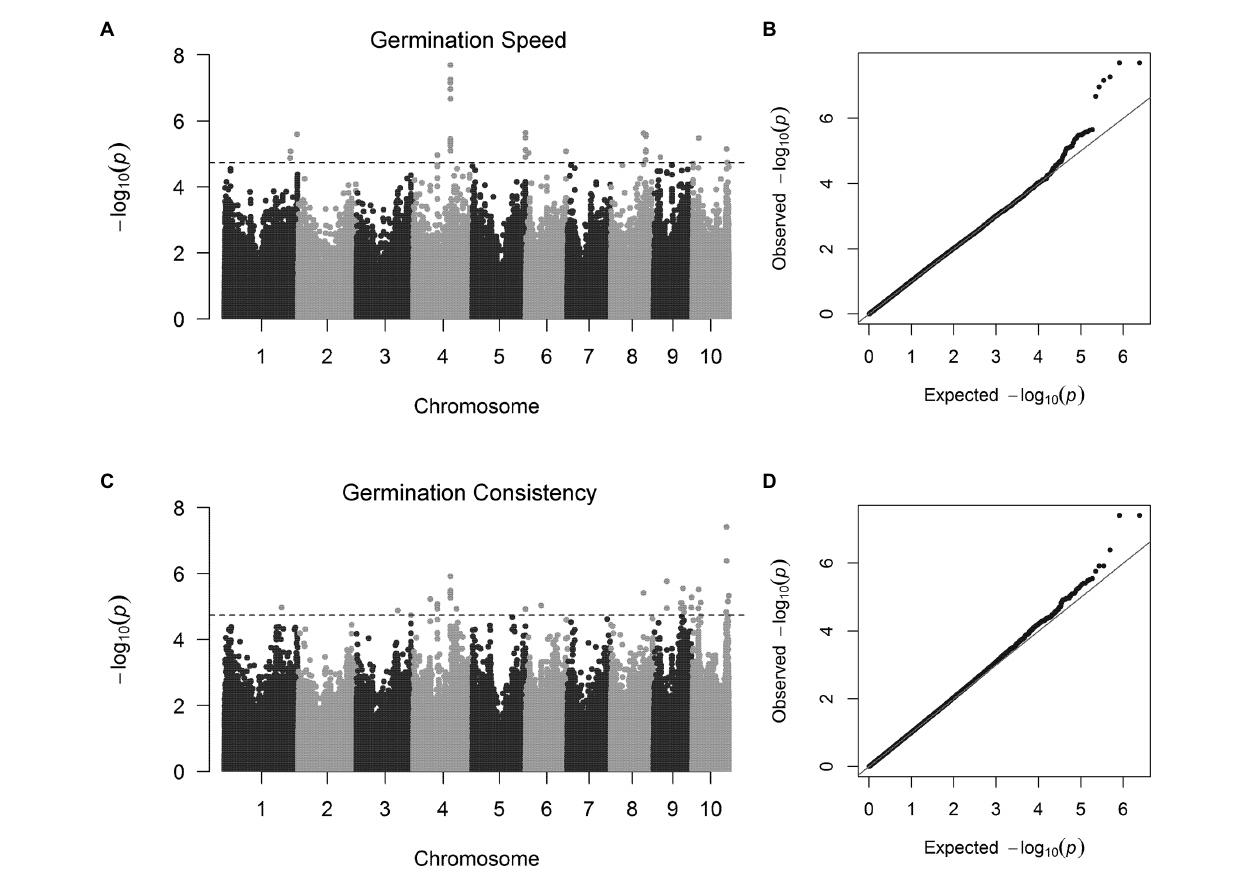
FIGURE 2 | Genome-wide association mapping of GS and GC using MLM method. The Manhattan plots show significant p -values associated with GS and GC from a genome-wide scans plotted against the position on each of the 10 chromosomes. Genomic locations and allele effects of significant SNPs located representative genes for GS and GC. The dashed line indicates the genome-wide significance thresholds of 1.82 × 10 − 5 . The vertical axis in quantile–quantile plots represents observed p -values and the horizontal axis indicates expected values. (A,B) are the Manhattan plot and quantile–quantile plot for GS, respectively. (C,D) are the Manhattan plot and quantile–quantile plot for GC,